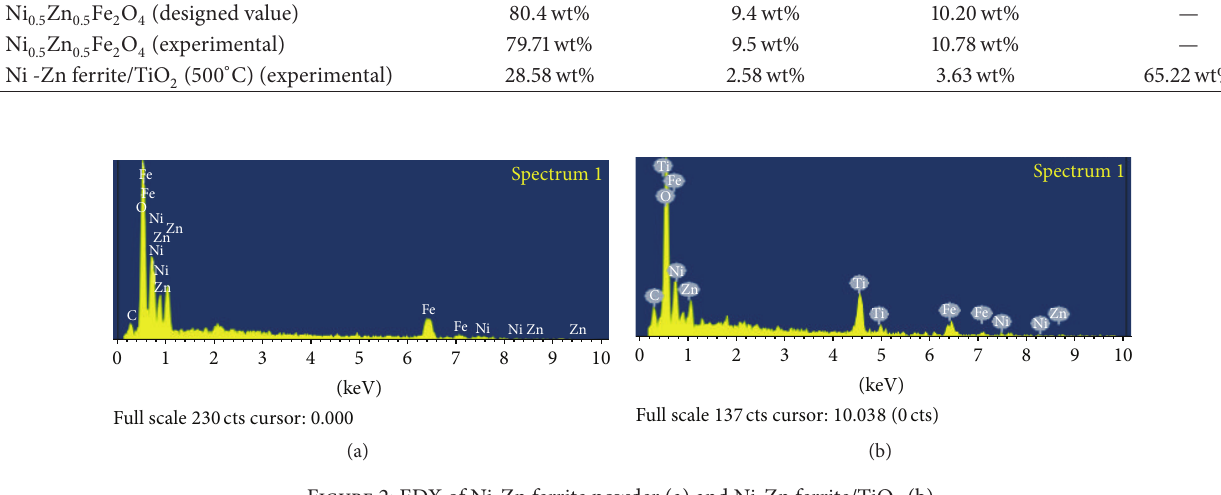
Figure 2: EDX of Ni-Zn ferrite powder (a) and Ni-Zn ferrite/TiO 2 (b).